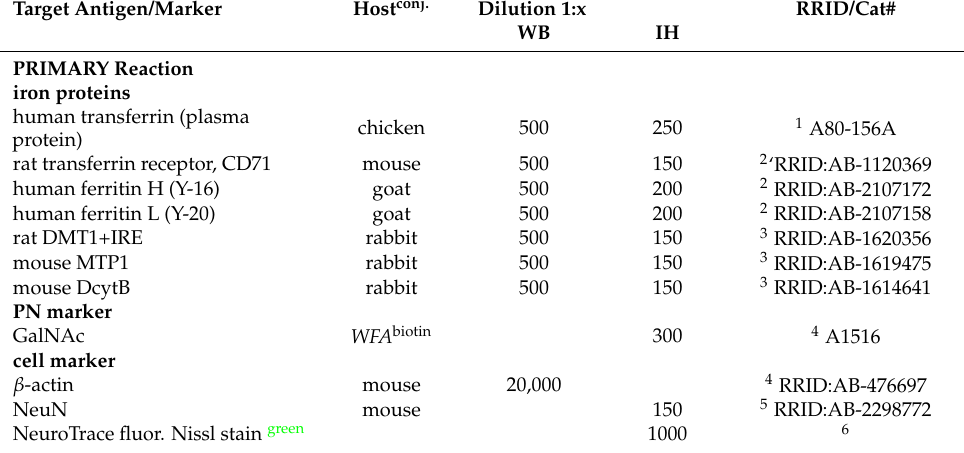
Table A1. Antibodies/markers used for the (lectin-/immuno)histochemical detection, and SBC and WB quantification. 1 biomol, 2 Santa Cruz, 3 adi, 4 Sigma-Aldrich, 5 Chemicon, 6 invitrogen, 7